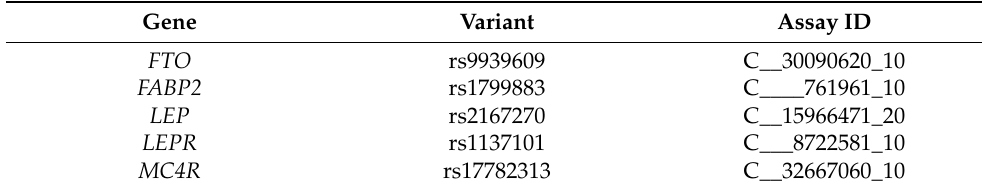
Table 3. SNP genotyping assays used in the